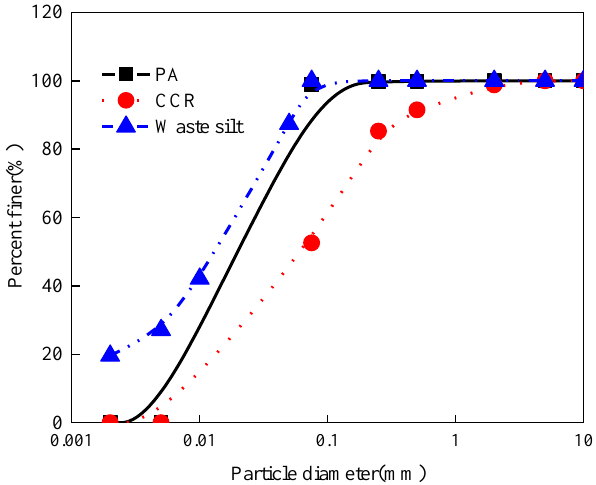
Figure 2. The grain size of silt PA, CCR, and waste silt.